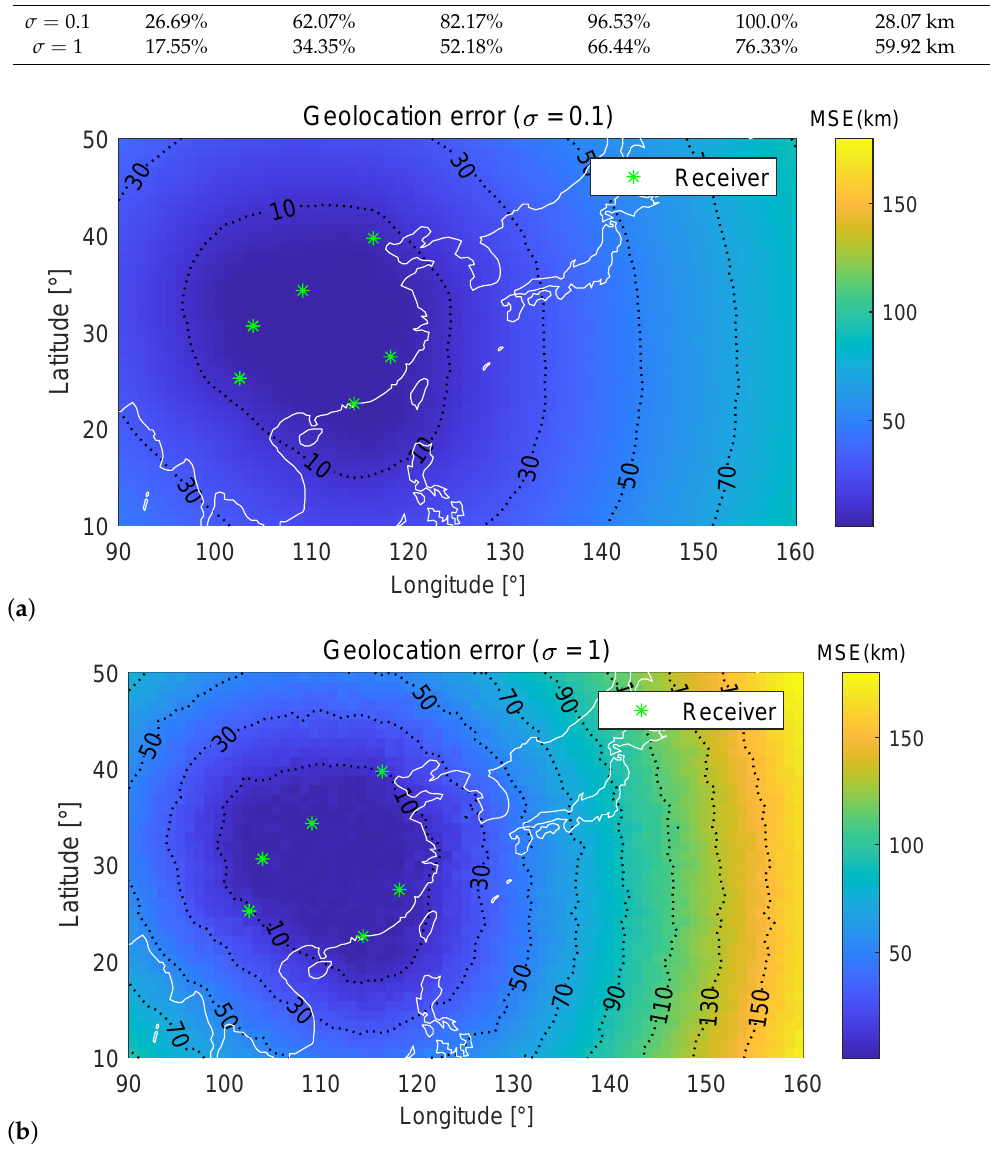
Figure 7. Geolocation error distributions for the second set of six fixed receivers under different σ